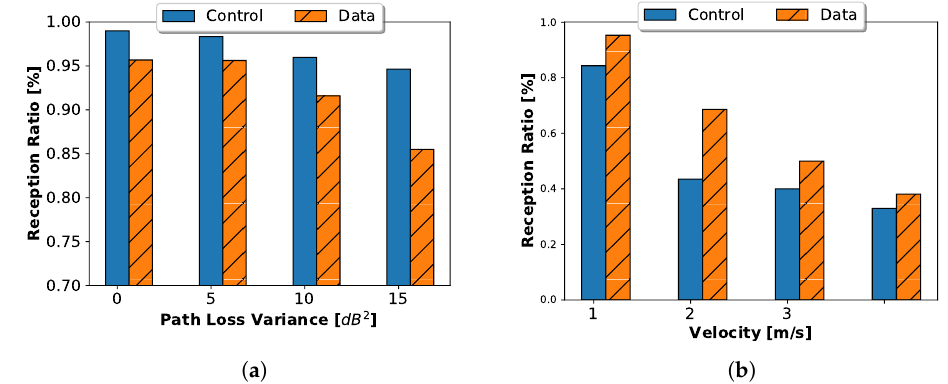
Figure 8. Simulation results for increasing ( a ) path loss variance and ( b )